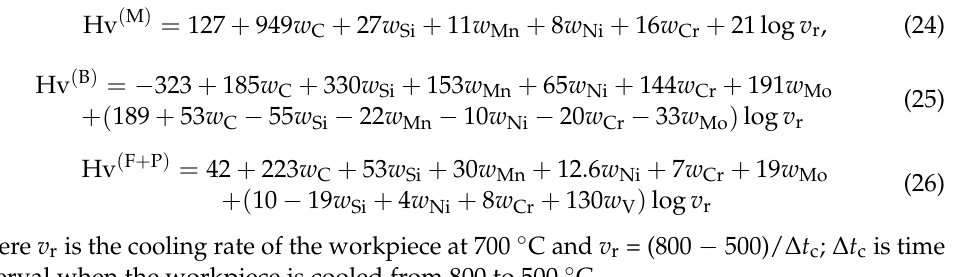
Table 3. The experimental conditions.